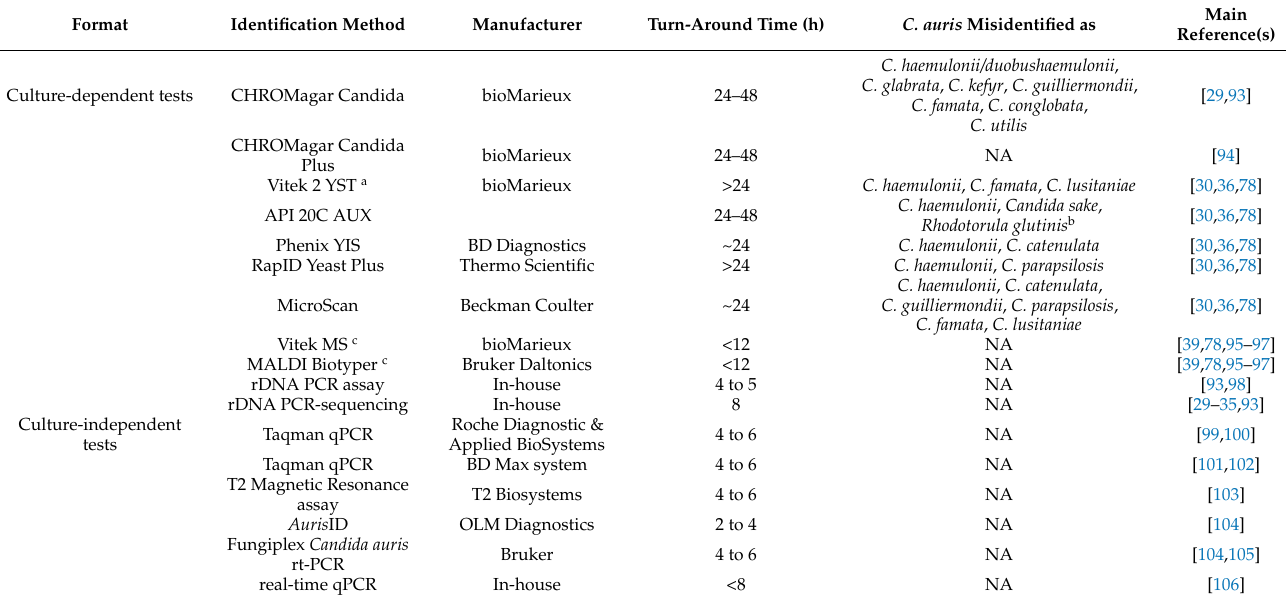
Table 2. Methods commonly used for the identification of C. auris in culture isolates and clinical